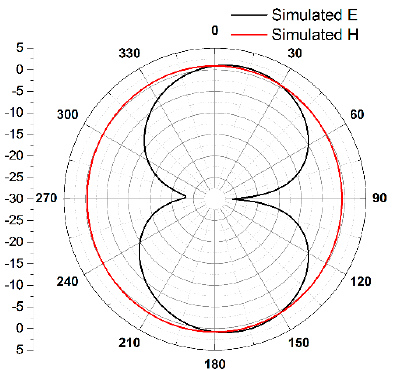
Figure 4. Simulated radiation pattern of the proposed antenna at 2.7 GHz.